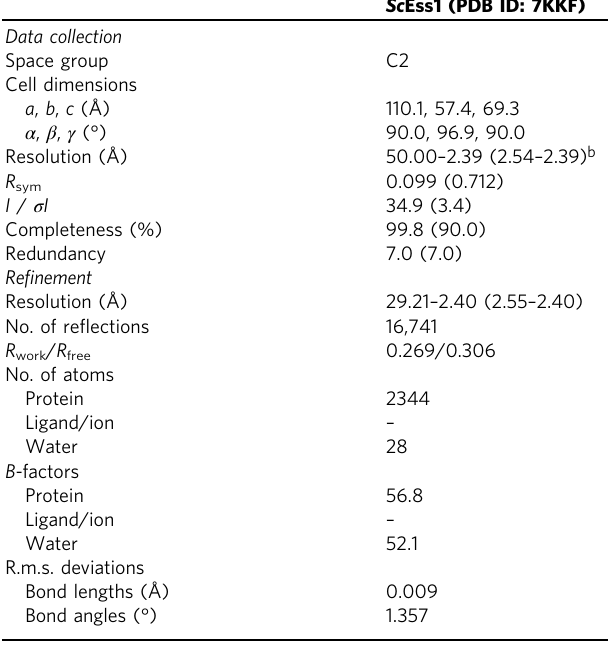
Table 1 Data collection and re fi nement statistics a